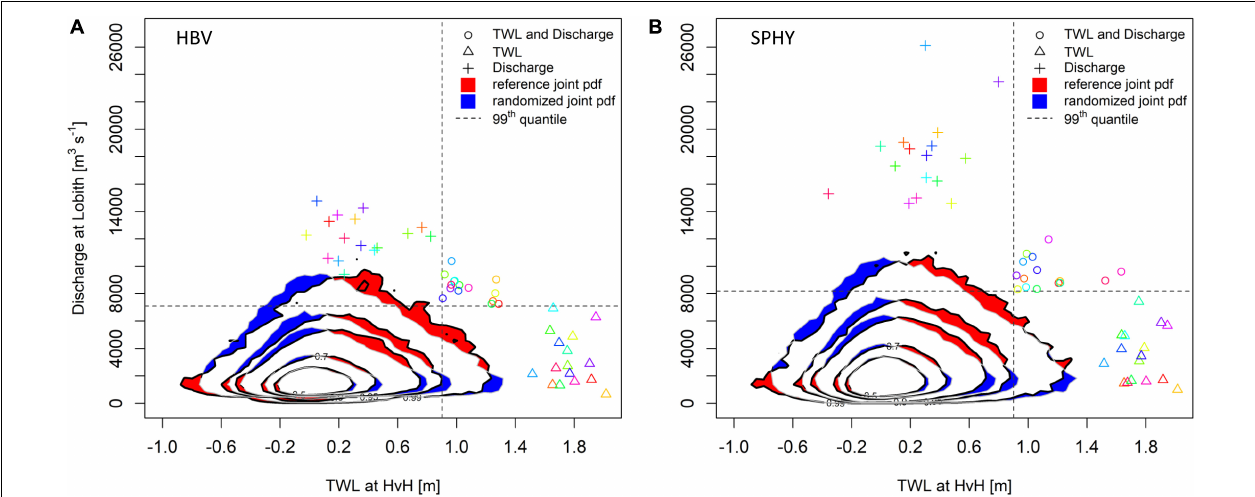
FIGURE 9 | Joint probability density for total water level at HvH and discharge at Lobith (3-day lagged) for winter 6 months period (A) HBV and (B) SPHY). The contours show different quantiles of the joint distribution (50 th , 70 th , 90 th , 95 th , and 99 th ). Shading is used to contrast density estimates from direct model output and randomized (shuffled) data, where correlations have been artificially removed. Red/blue shading indicates regions where model data is more/less populated than the shuffled data. The thin dashed lines show the 99 th quantiles of each variable in the respective dataset. The colored points correspond to the highest TWL ( (cid:49) ), discharge (+) and compound events (o) for individual ensemble